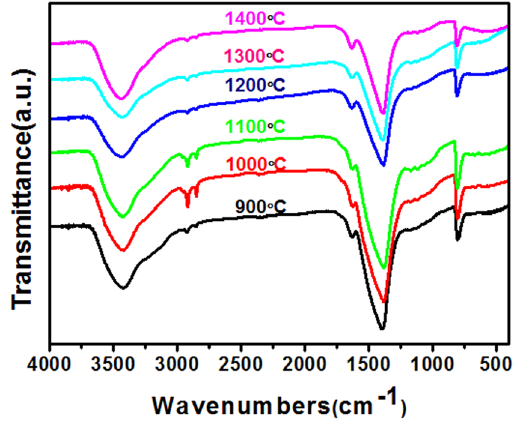
Figure 2. FTIR spectra of porous BN microfibers prepared at different calcination temperatures.